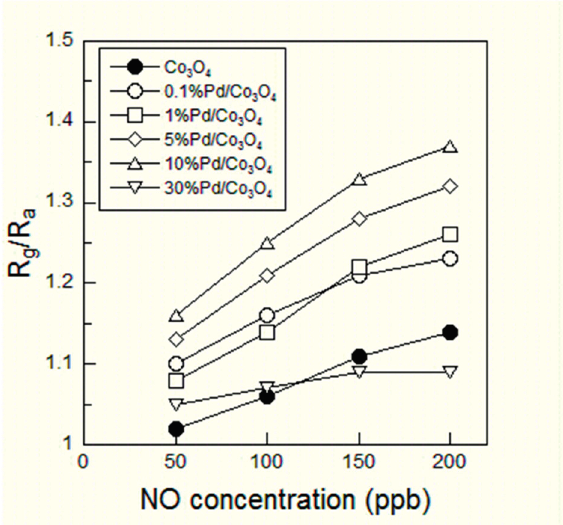
Figure 3. Sensor responses of the sensor element using Co 3 O 4 , 0.1%Pd/Co 3 O 4 , NO gas concentration.